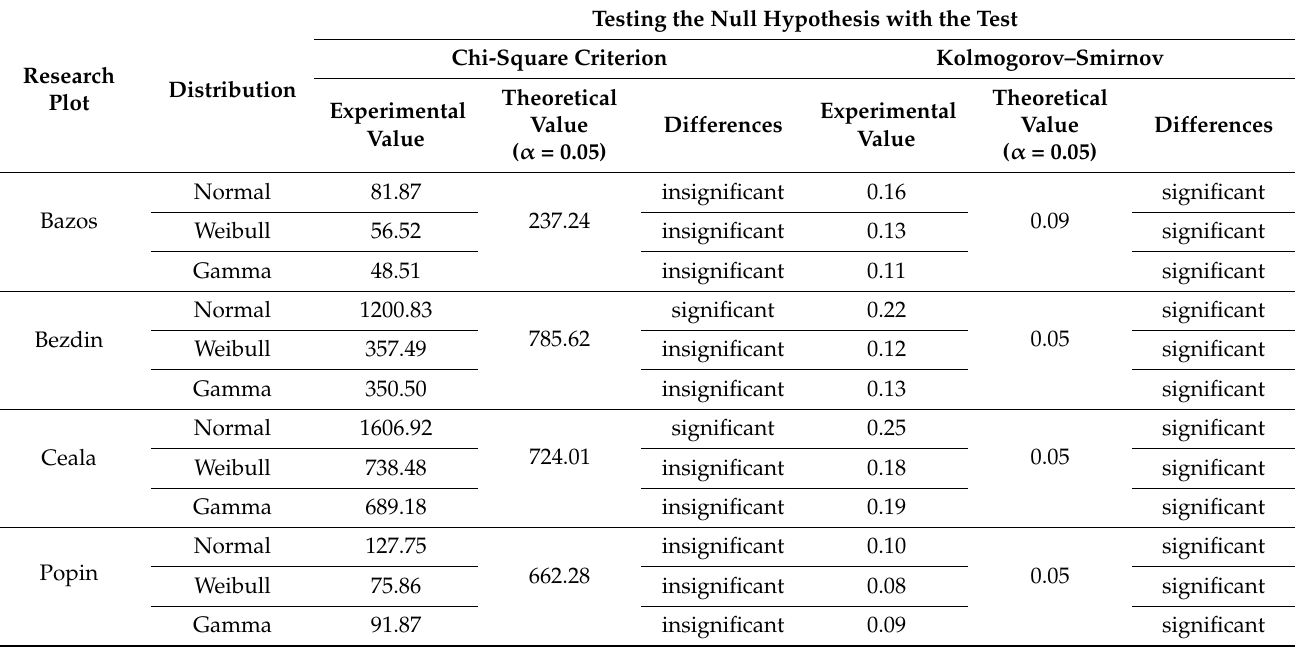
Table 2. Results of applying statistical tests to the experimental distribution of